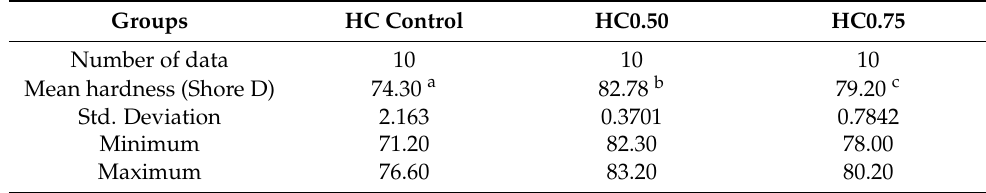
Figure 7. Optical micrographs (×2) of Heat Cure (HC) and Cold Cure (CC) samples' surfaces with and without Ag-Zn zeolite at different concentrations (0.50 wt.% and 0.75 wt.%). Table 5. Mean values of surface hardness (Shore D) in the HC acrylic resin incorporated with Ag-Zn zeolite at different weight percentages (0.50 wt.% and 0.75 wt.%) and without any Ag-Zn zeolite (control group). Different superscript letters represent significant statistical differences ( p < 0.05).